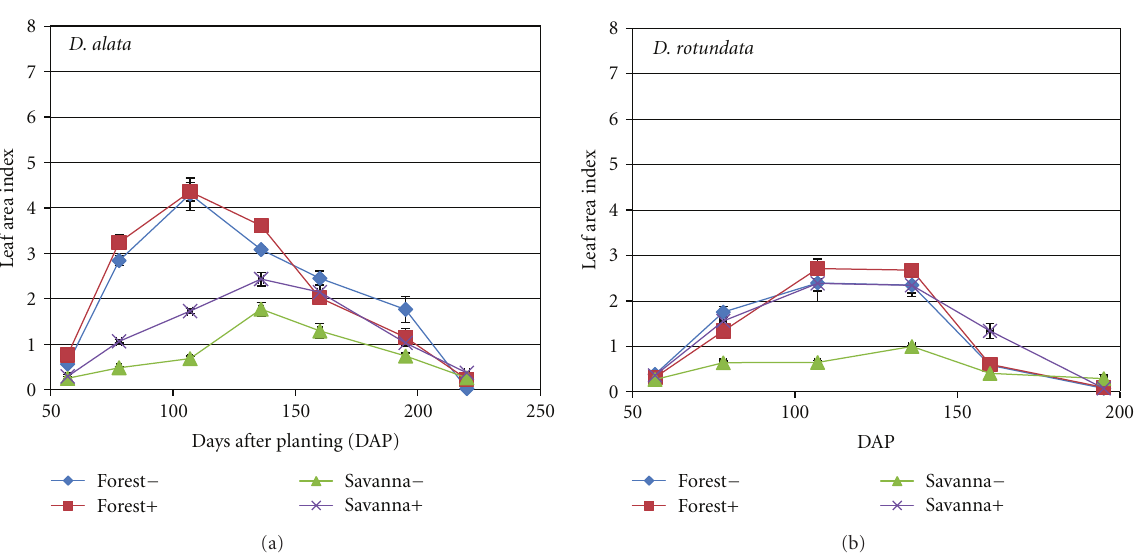
Figure 2: Leaf area index of Dioscorea spp. grown in a forest and savanna sites with (+) and without ( − ) fertilizer application. Error bars represent standard error of